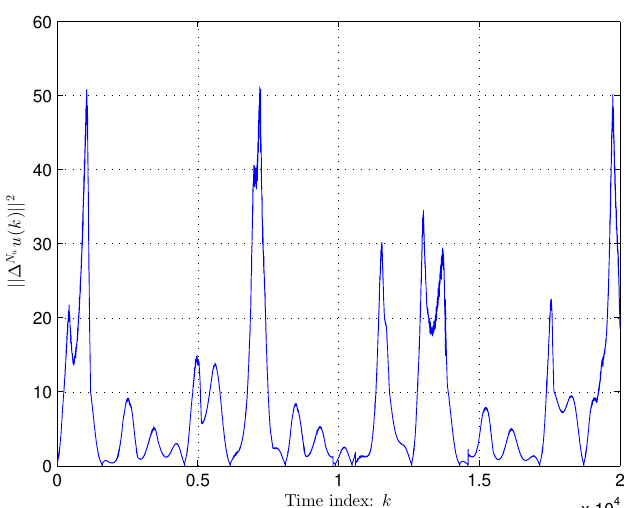
Figure 8. Plot of | ∆ N u α u ( k ) | 2 : with disturbance d s ( k )